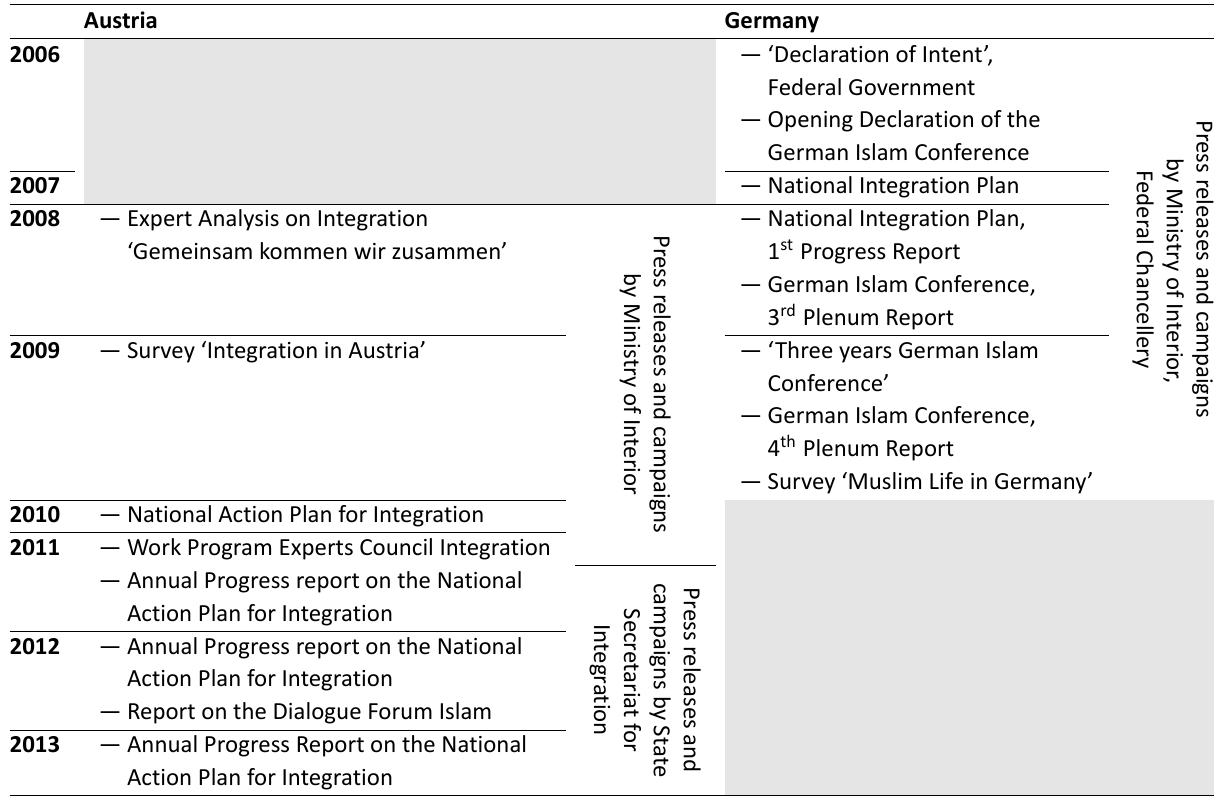
Table 1. Overview data